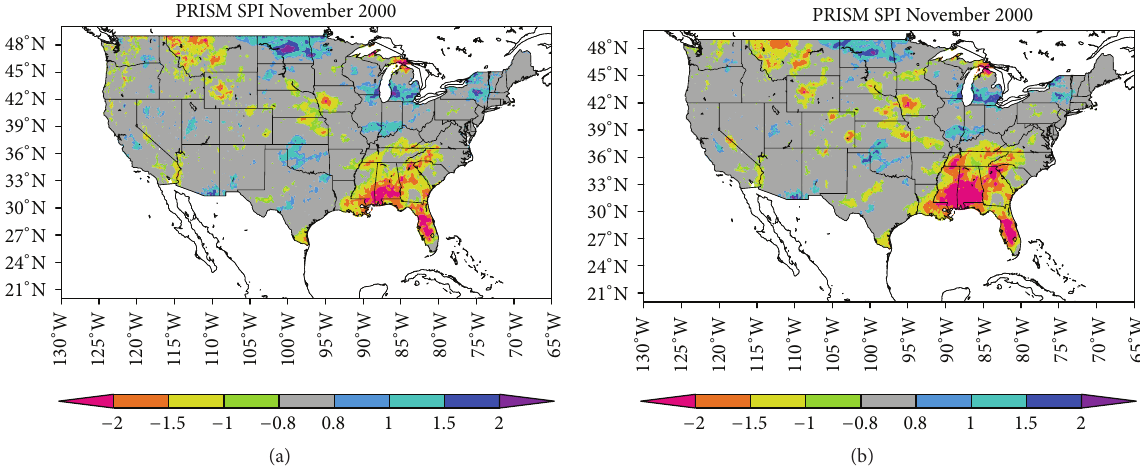
Figure 3: 12-month SPI ending in November 2000 computed using PRISM for (a) 1940–2006 (long record) and (b) 1988–2006 (short record).